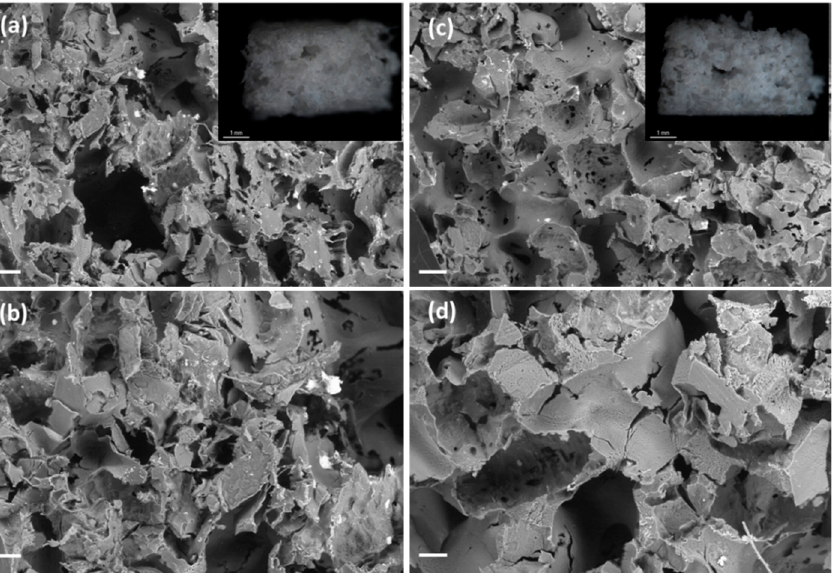
Figure 8. SEM images of cross sections of ( a , b ) PCL(5K)75BA and ( c , d ) PCL(10K)75BA polymeric scaffolds loaded with 5 and 10 wt.% of ketoprofen, respectively, after 21 days in PBS pH 7.4 medium. Insets in ( a , c ): Optical micrographs of the scaffolds. Scale bars ( a , c ): 200 µm; ( b , d ) 100 µm; (insets) 1 mm.